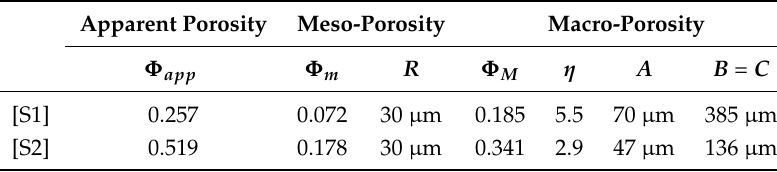
Table 1. Measured porosities in [S1] and [S2], and geometrical parameters for the PSM/PEM model.